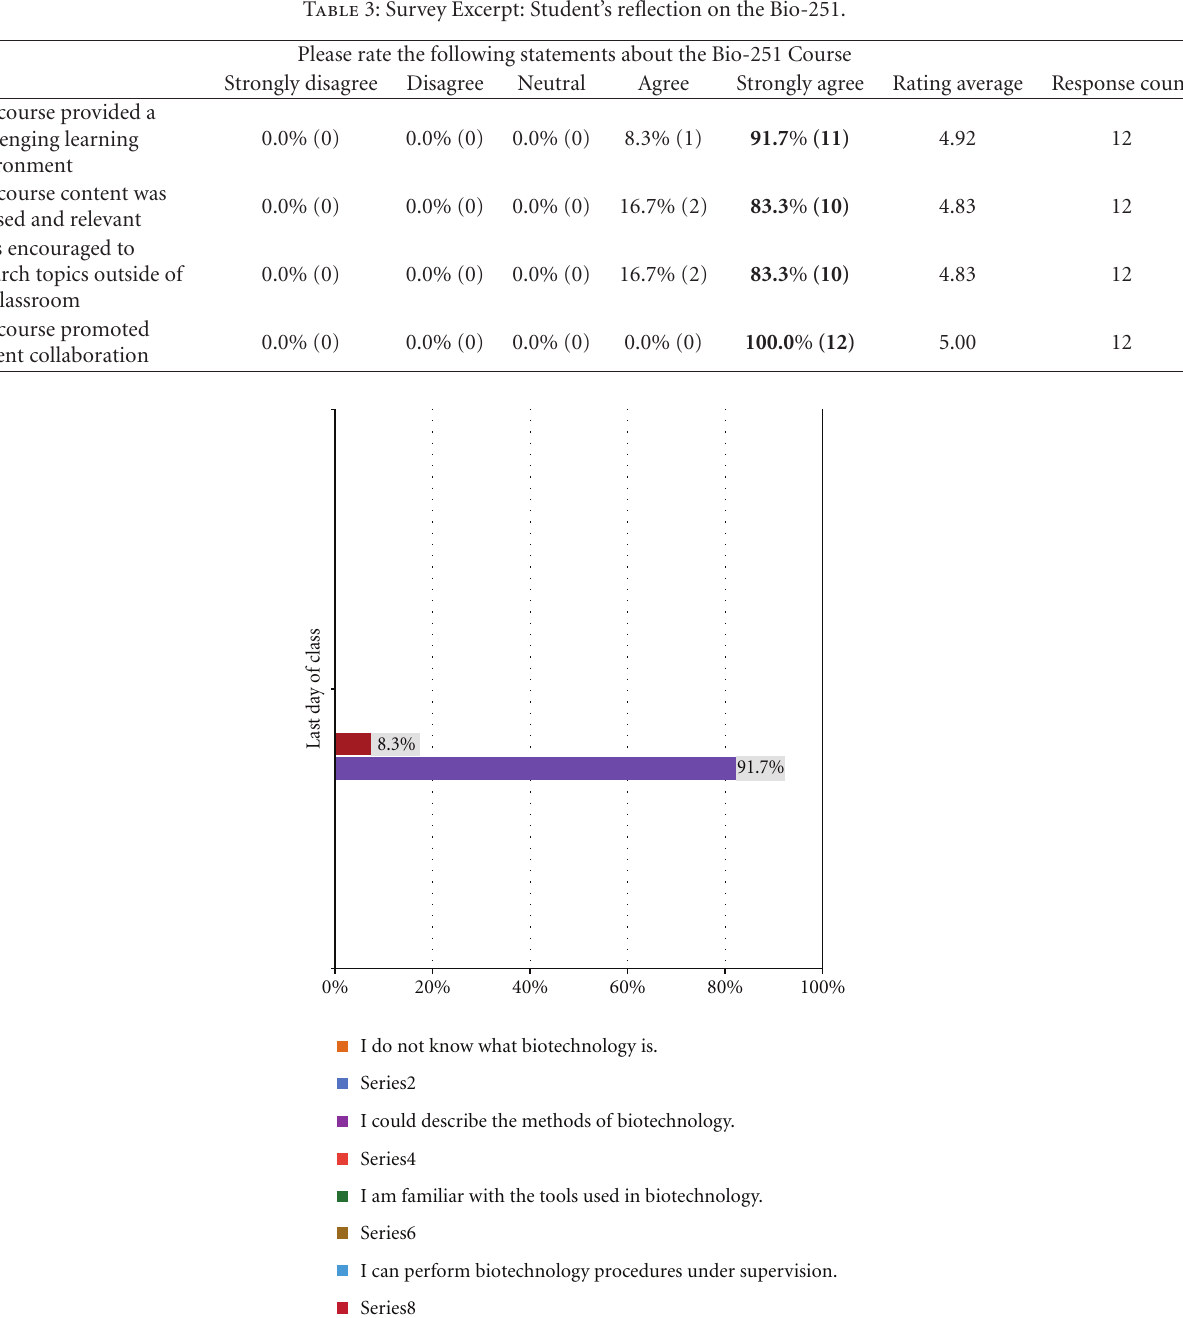
Table 3: Survey Excerpt: Student’s reflection on the Bio-251.